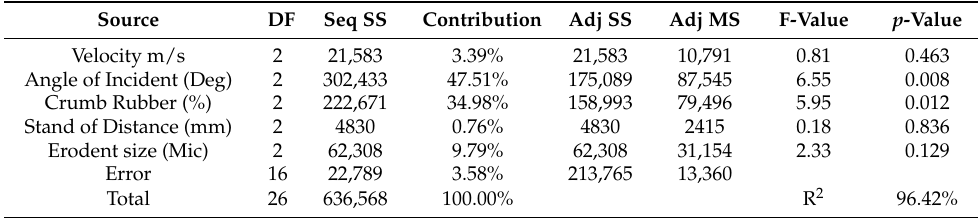
Table 4. Analysis of Variance for Transformed Response (Erosion Rate).